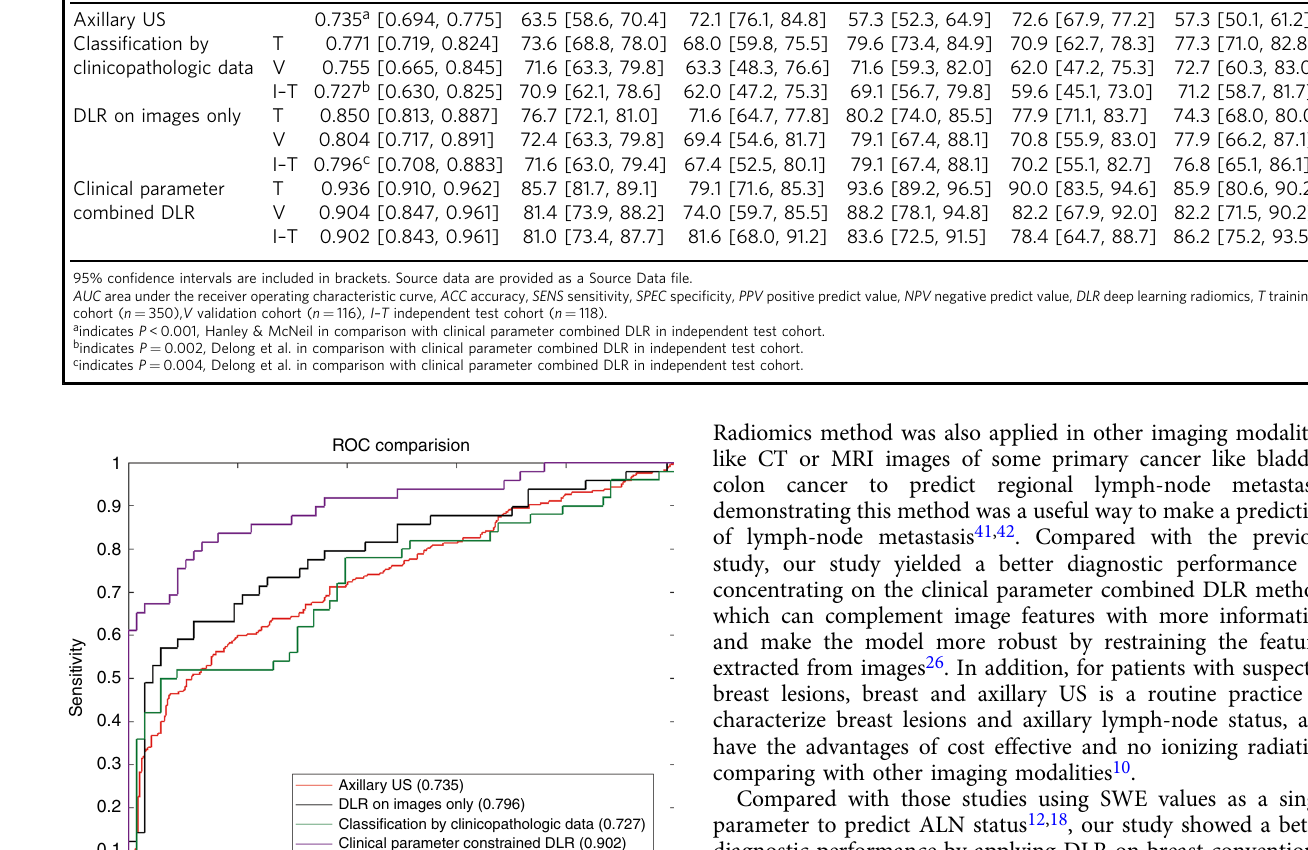
Table 3 The prediction of ALN status results (N0 v.s. N + ( ≥ 1)). Methods